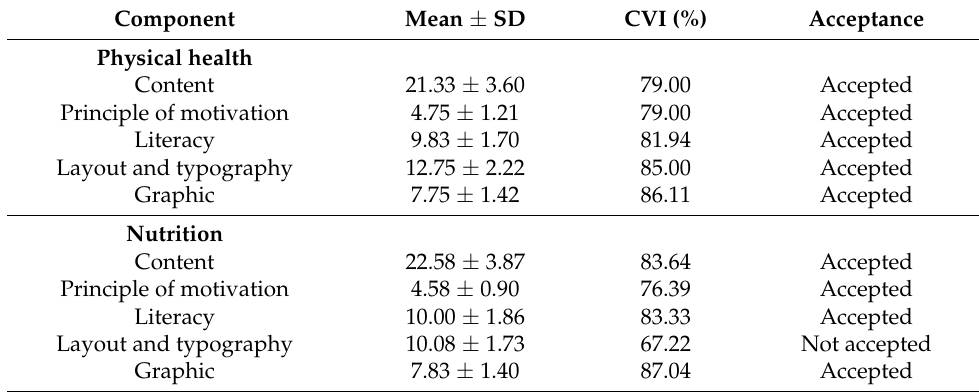
Table 6. Module criterion assessment